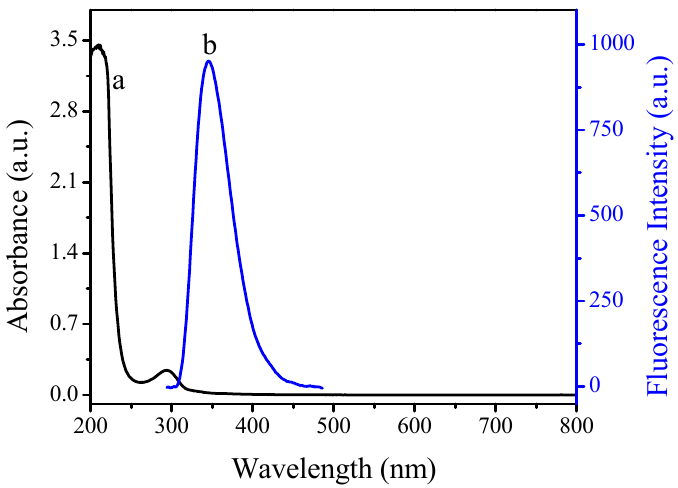
Figure 1. UV-vis absorption spectrum and fluorescence (FL) emission spectrum of the carbon quantum dots (C-dots) excitated at 295 nm.